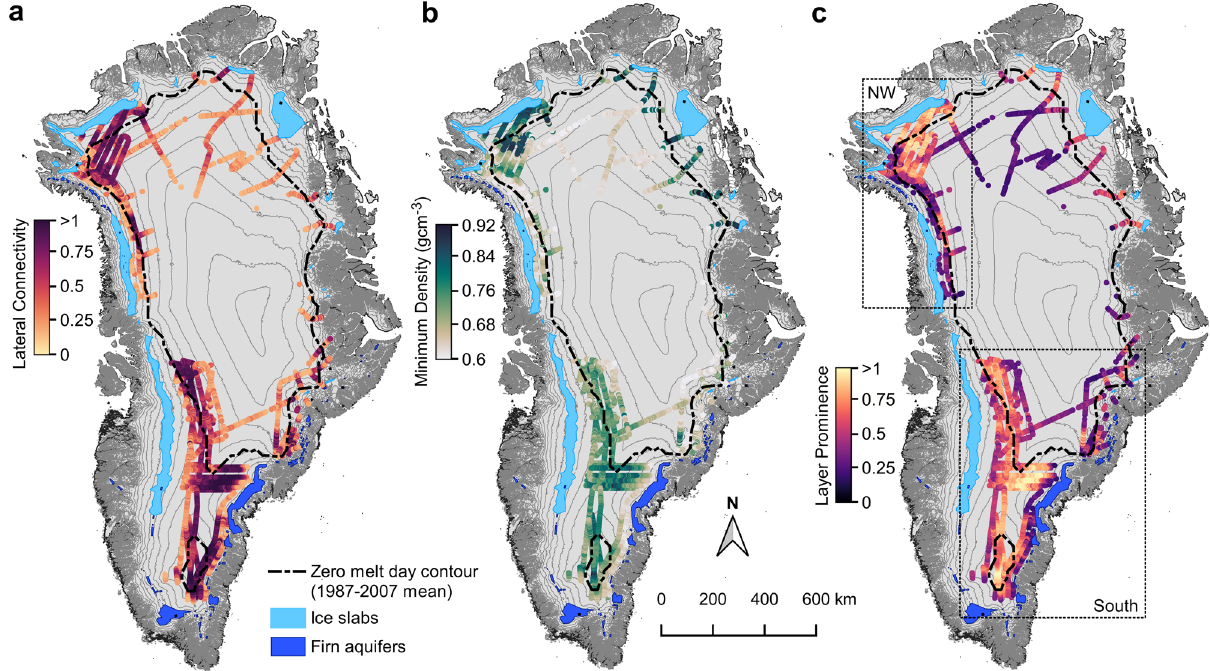
Fig. 2 Radar-derived characterization of the 2012 melt layer. a Horizontal connectivity of the 2012 melt layer, shown by color shading along fl ight transects. A score of 1 or greater indicates a perfectly connected layer, with dark colors indicating high connectivity. b Minimum layer density consistent with observed radar re fl ectivities, shown in color shading along fl ight transects. Dark green dots indicate high-density regions. c Radar-inferred layer prominence, shown in color shading along fl ight transects. Light yellow regions indicate high layer prominence. Dark blue polygons show fi rn aquifer extent 42 , light blue polygons the ice slab extent 9 , and the dashed black line the 1987 – 2007 average zero melt day contour derived from passive microwave data 64 . Surface elevation contours (200 m interval) are shown in gray. The dashed black boxes in c show the regions referred to as northwest and southern Greenland in the climatological analysis and Fig.